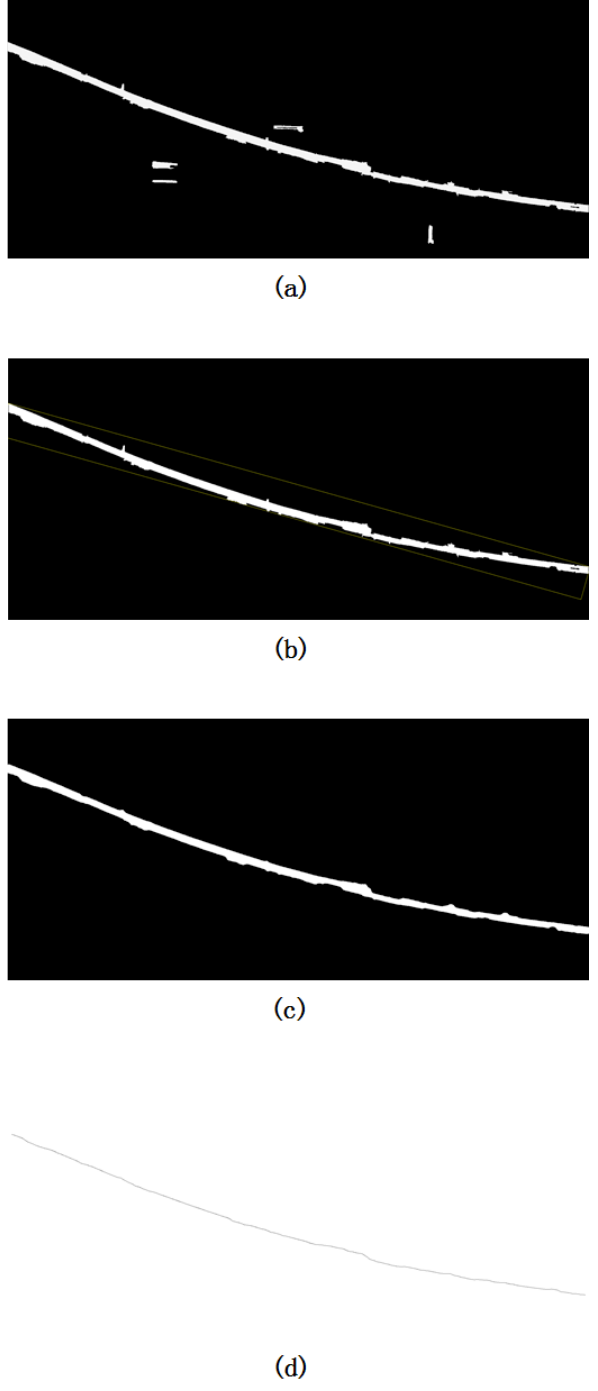
Figure 13. (a)Before shape analysis (b)After shape analysis (c)Pruned road (d)Extracted center line of road